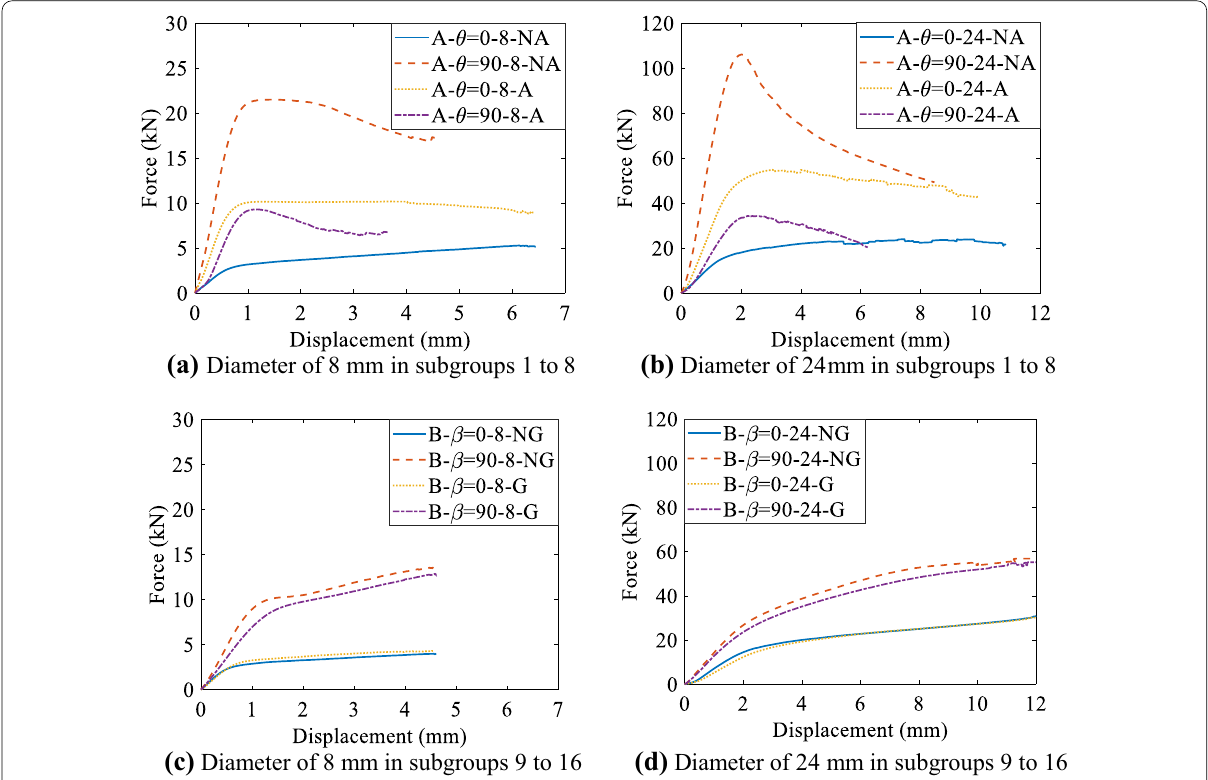
(c) Diameter of 8 mm in subgroups 9 to 16 (d) Diameter of 24 mm in subgroups 9 to 16 Fig. 6 Average force–displacement curves of the CLT embedment specimens